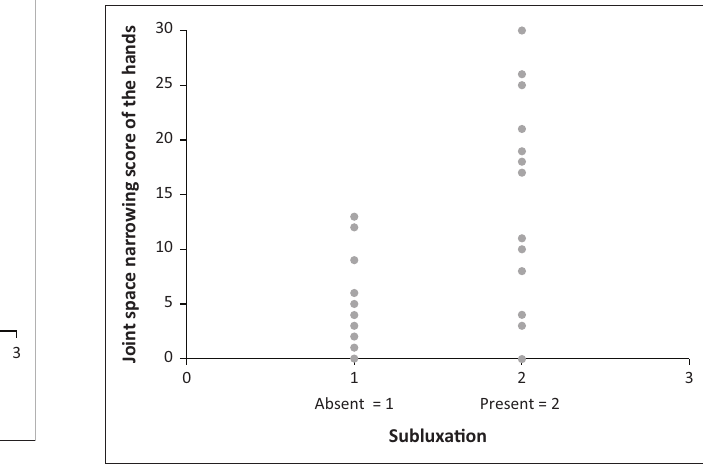
FIGURE 2: Correlation between the Simple Erosion Narrowing Score of the hands and the prevalence of cervical spine subluxation. TABLE 3: Simplified erosion narrowing score of hands, presence of erosions and joint space narrowing as predictors of cervical spine subluxation. Indicator